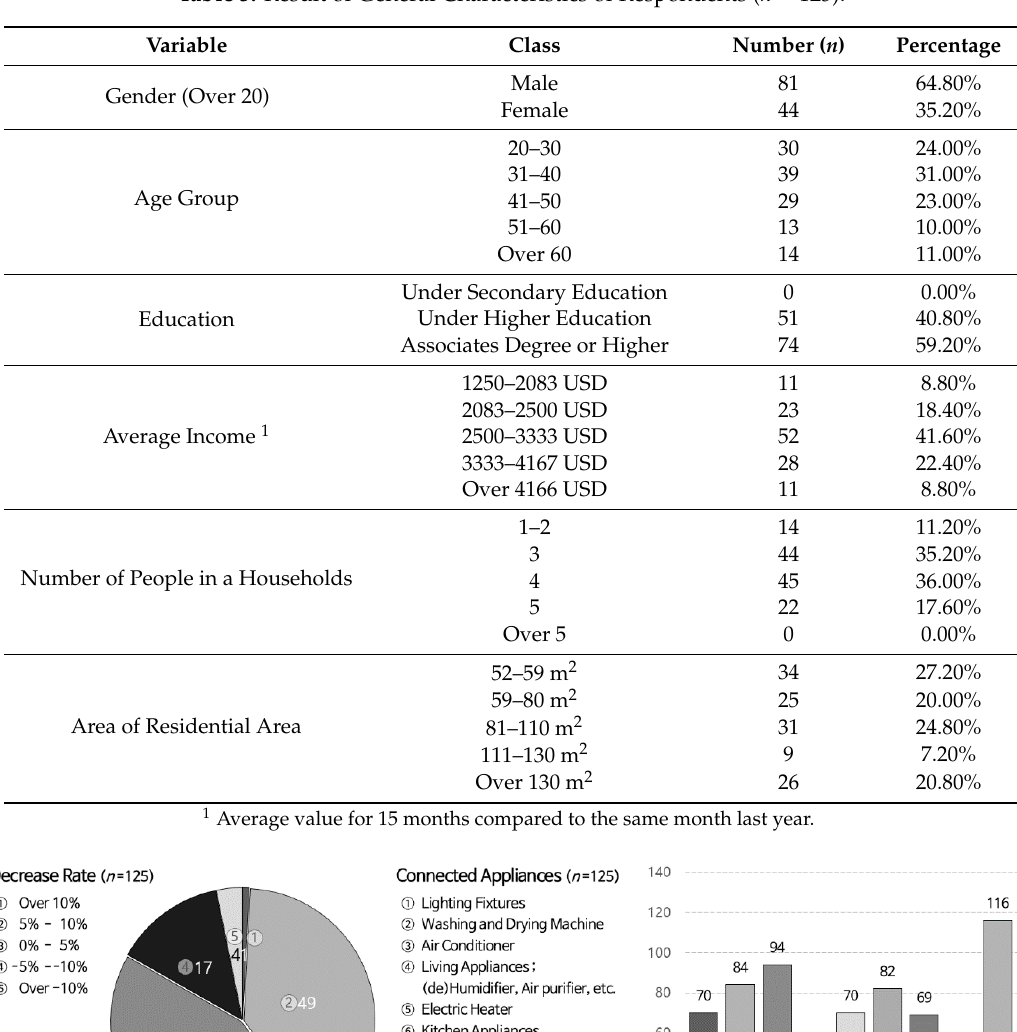
Figure 1. Result of electric power decrease rate of the program participants for 15 months compared